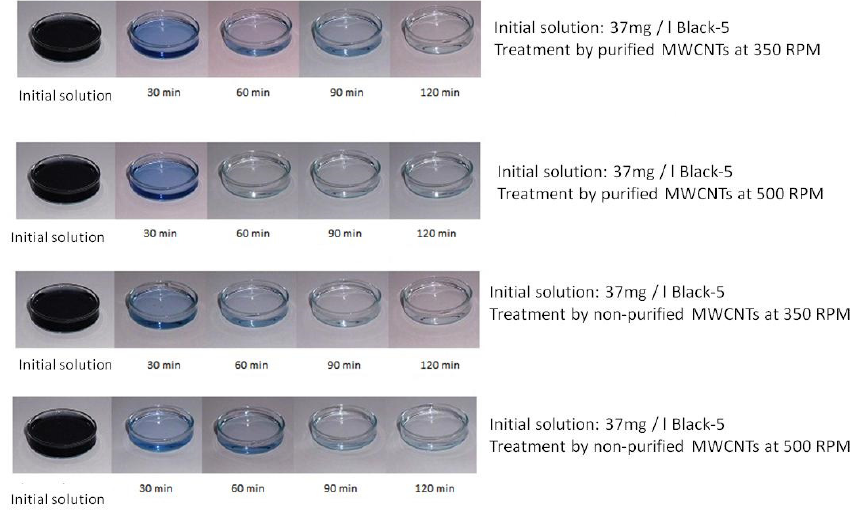
Figure 4. Qualitative trend of the different shades of coloring of the solution according to type of nanotubes used, purified and nonpurified, and the stirring speed (RPM-revolutions per minute).